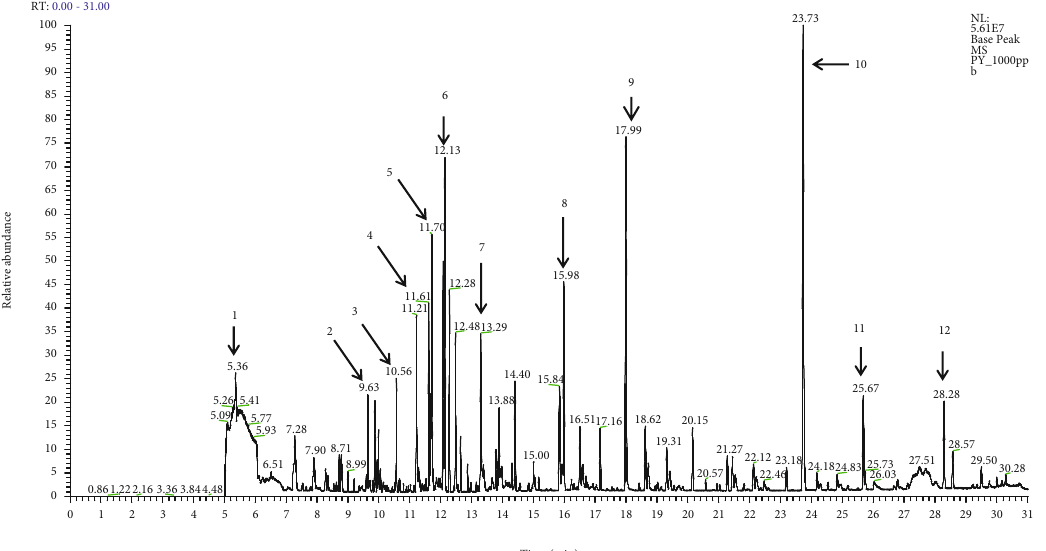
Figure 2: Chromatogram of volatile compound extraction from pepper whisky: 1: acetaldehyde; 2: ethyl acetate; 3: hexyl acetate; 4: methanol, 5: n-propanol, 6: iso-butanol; 7: ethyl butanoate; 8: n-butanol; 9: 2-methyl-1-butanol; 10: 3-methyl-1-butanol; 11: piperine; 12: